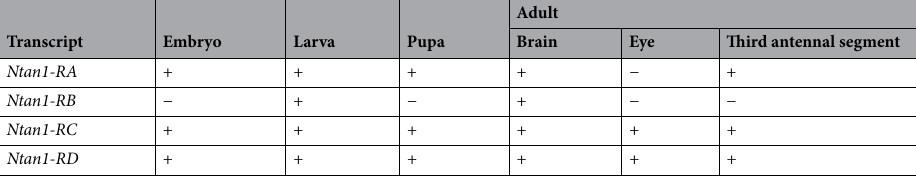
Table 1. Summary of the results obtained in the gene expression analysis by RT-PCR of the Ntan1 transcripts in different developmental stages and adult organs of wildtype genotype Canton-S . Negative symbol (−) indicates total absence of gene expression and positive symbol (+) indicates gene expression of the Ntan1 transcripts.